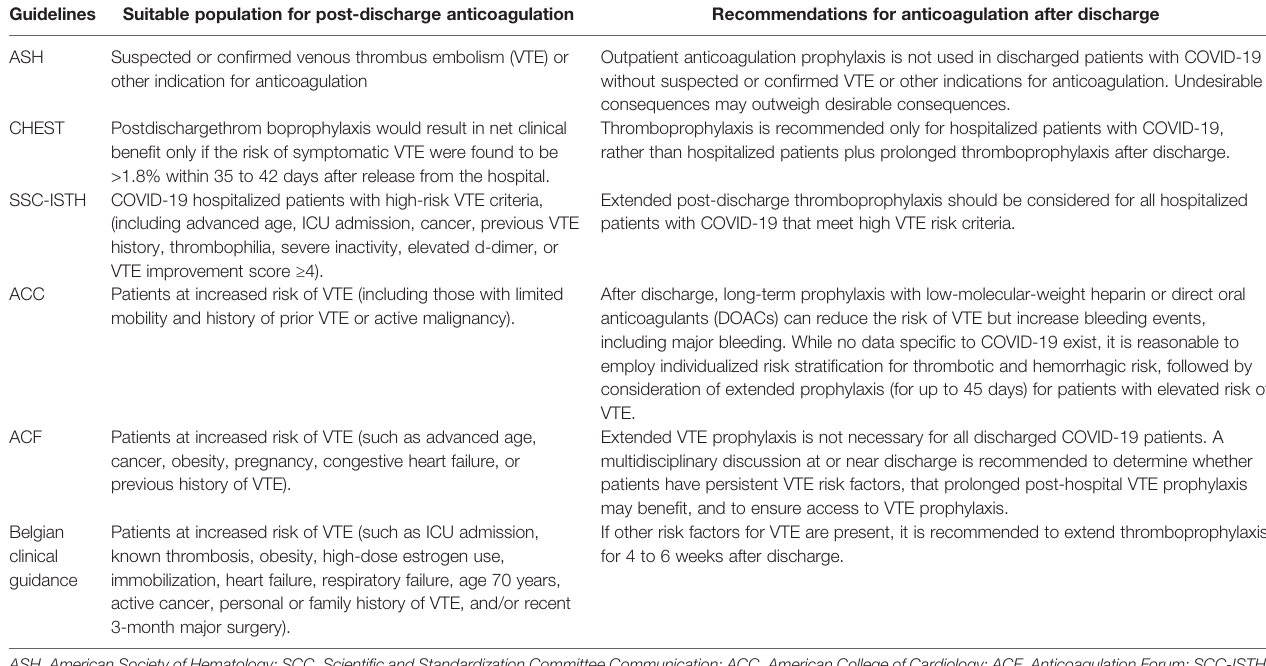
TABLE 3 | Recommendations of guidelines for thromboprophylaxis after